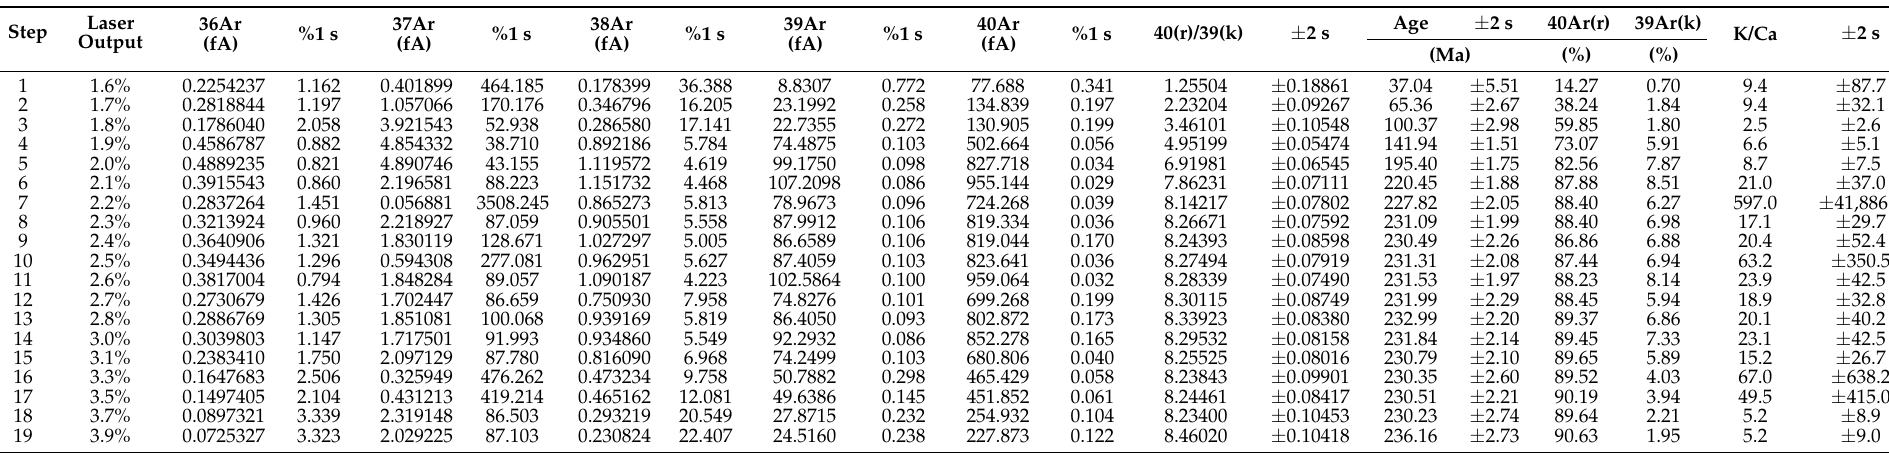
Table A3. Results of 40 Ar/ 39 Ar laser stepwise heating analysis of biotite for the hornblende gabbro of the Baogeqi gabbro